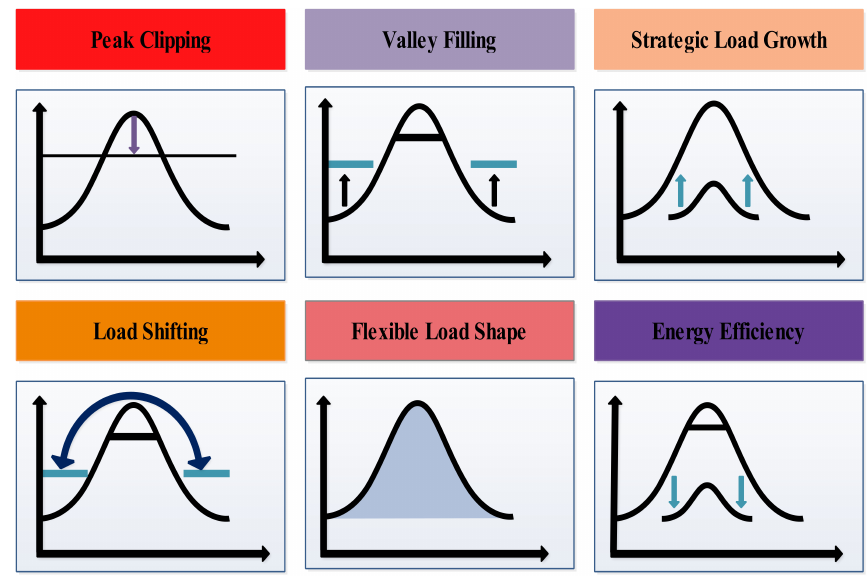
Figure 5. Various DSM load share